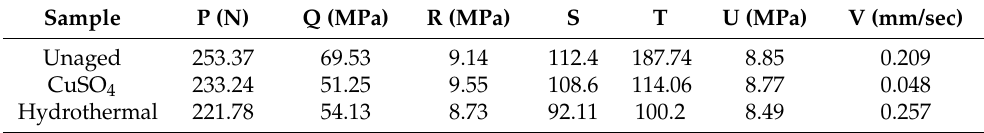
Table 1. Variation of tensile properties of